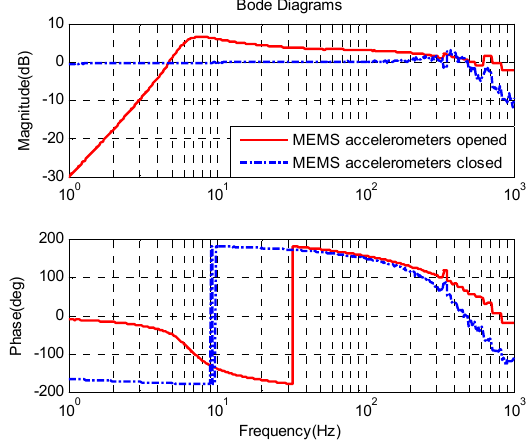
Figure 10. FSM acceleration response.